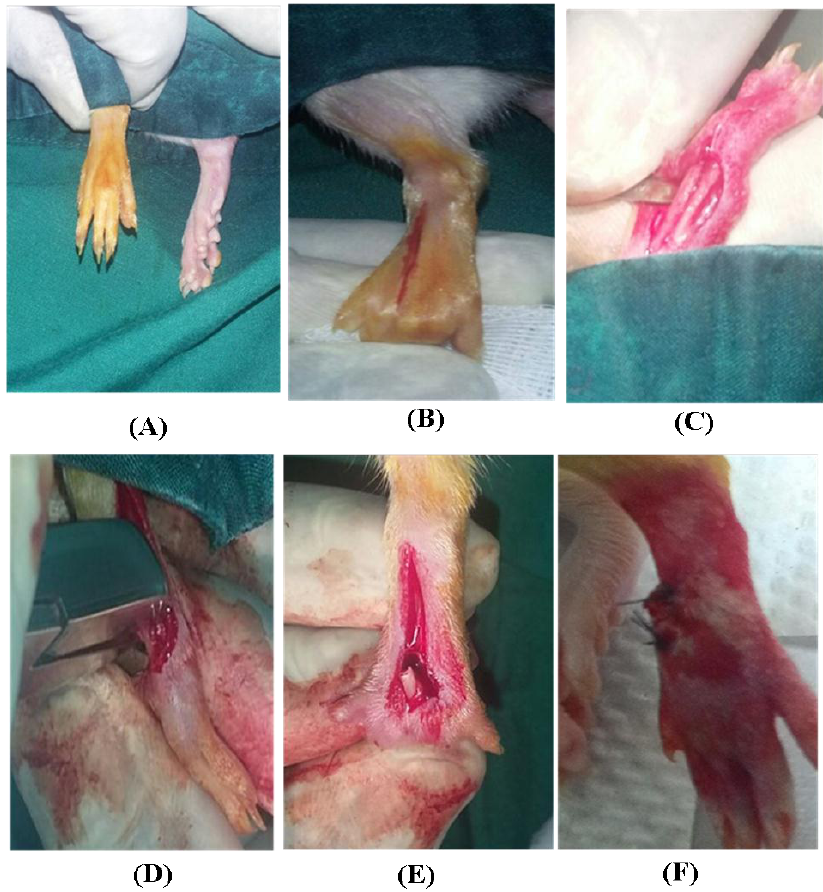
Figure 2. Photographs of sequential surgical steps of creating 3rd metatarsal transverse mid shaft fracture. (A) final skin preparation with povidone iodine and drapping of the surgical site, (B) skin incision directly on the 3rd metatarsal bone, (C) exposure of the metatarsal bones, (D) fracture creation with Liston bone cutting forceps, (E) transverse mid shaft fracture created, and (F) single layered skin closure with ethilon non absorbable suture in simple interrupted closure pattern after anatomical reduction of the fractured